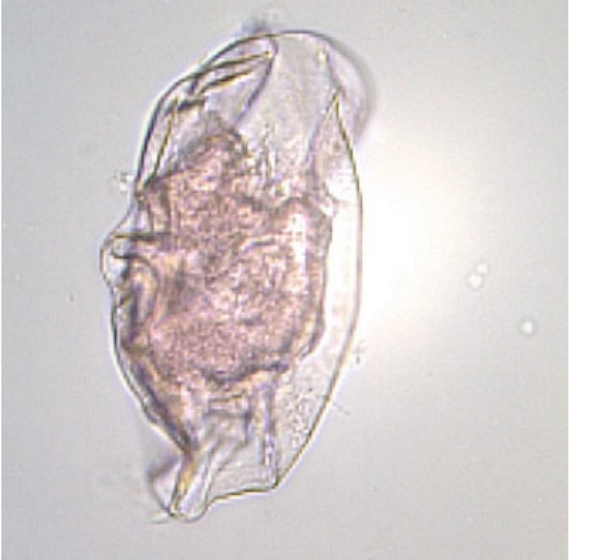
Image 4. Lophocharis salpina (Ehrenberg), lateral view Image 5. Mytilina bisulcata (Lucks), lateral view